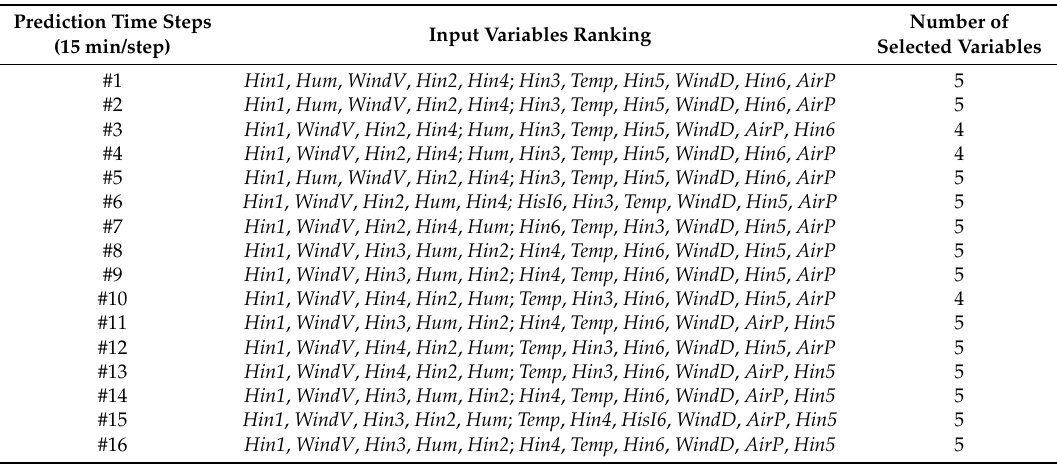
Table 2. Ranking and selection of candidate variables for Xuqiao Farm.